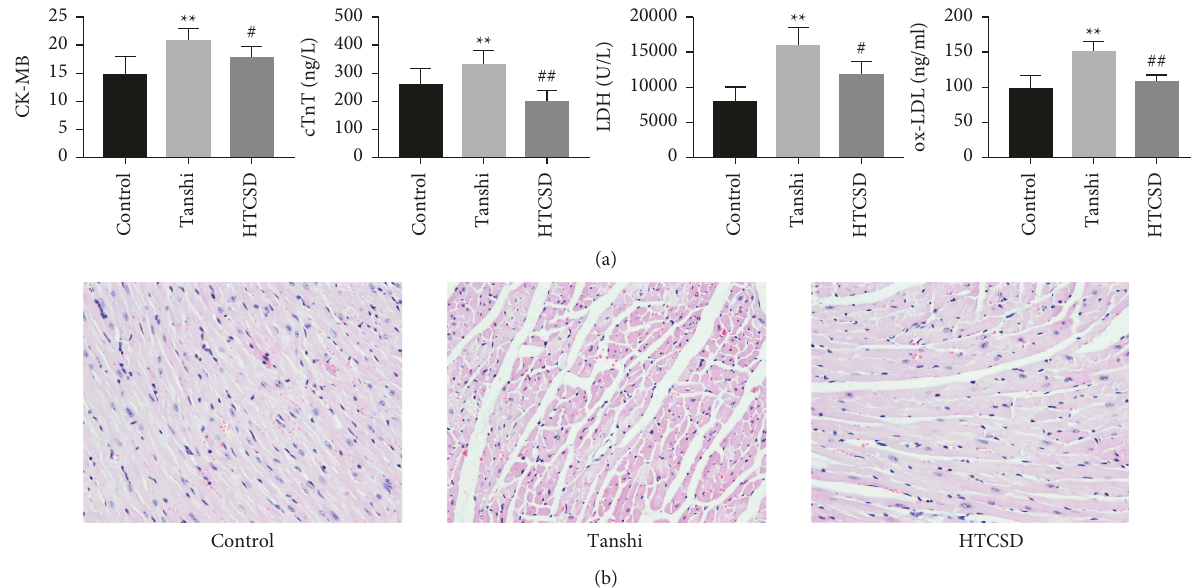
Figure 2: Serum biochemical analysis and histomorphology. (a) Serums were collected to evaluate the levels of CK-MB, cTnT, LDH, and oxLDL and are shown as mean ± S .D ( n � 5–6). ∗∗ P -value < 0.01 (Tanshi vs Control), ## P -value < 0.01 (HTCSD vs Tanshi), and # P -value < 0.05 (HTCSD vs Tanshi). (b) H&E staining (scale bar � 50 μ m) was used to observe the pathological changes of the myocardium of the left ventricle. Abbreviations: CK-MB: creatine phosphokinase-Mb, cTnT: cardiac troponin T LDH: lactic dehydrogenase, oxLDL: oxidized low- density lipoprotein, H&E: hematoxylin and eosin. HTCSD: Huo-Tan-Chu-Shi